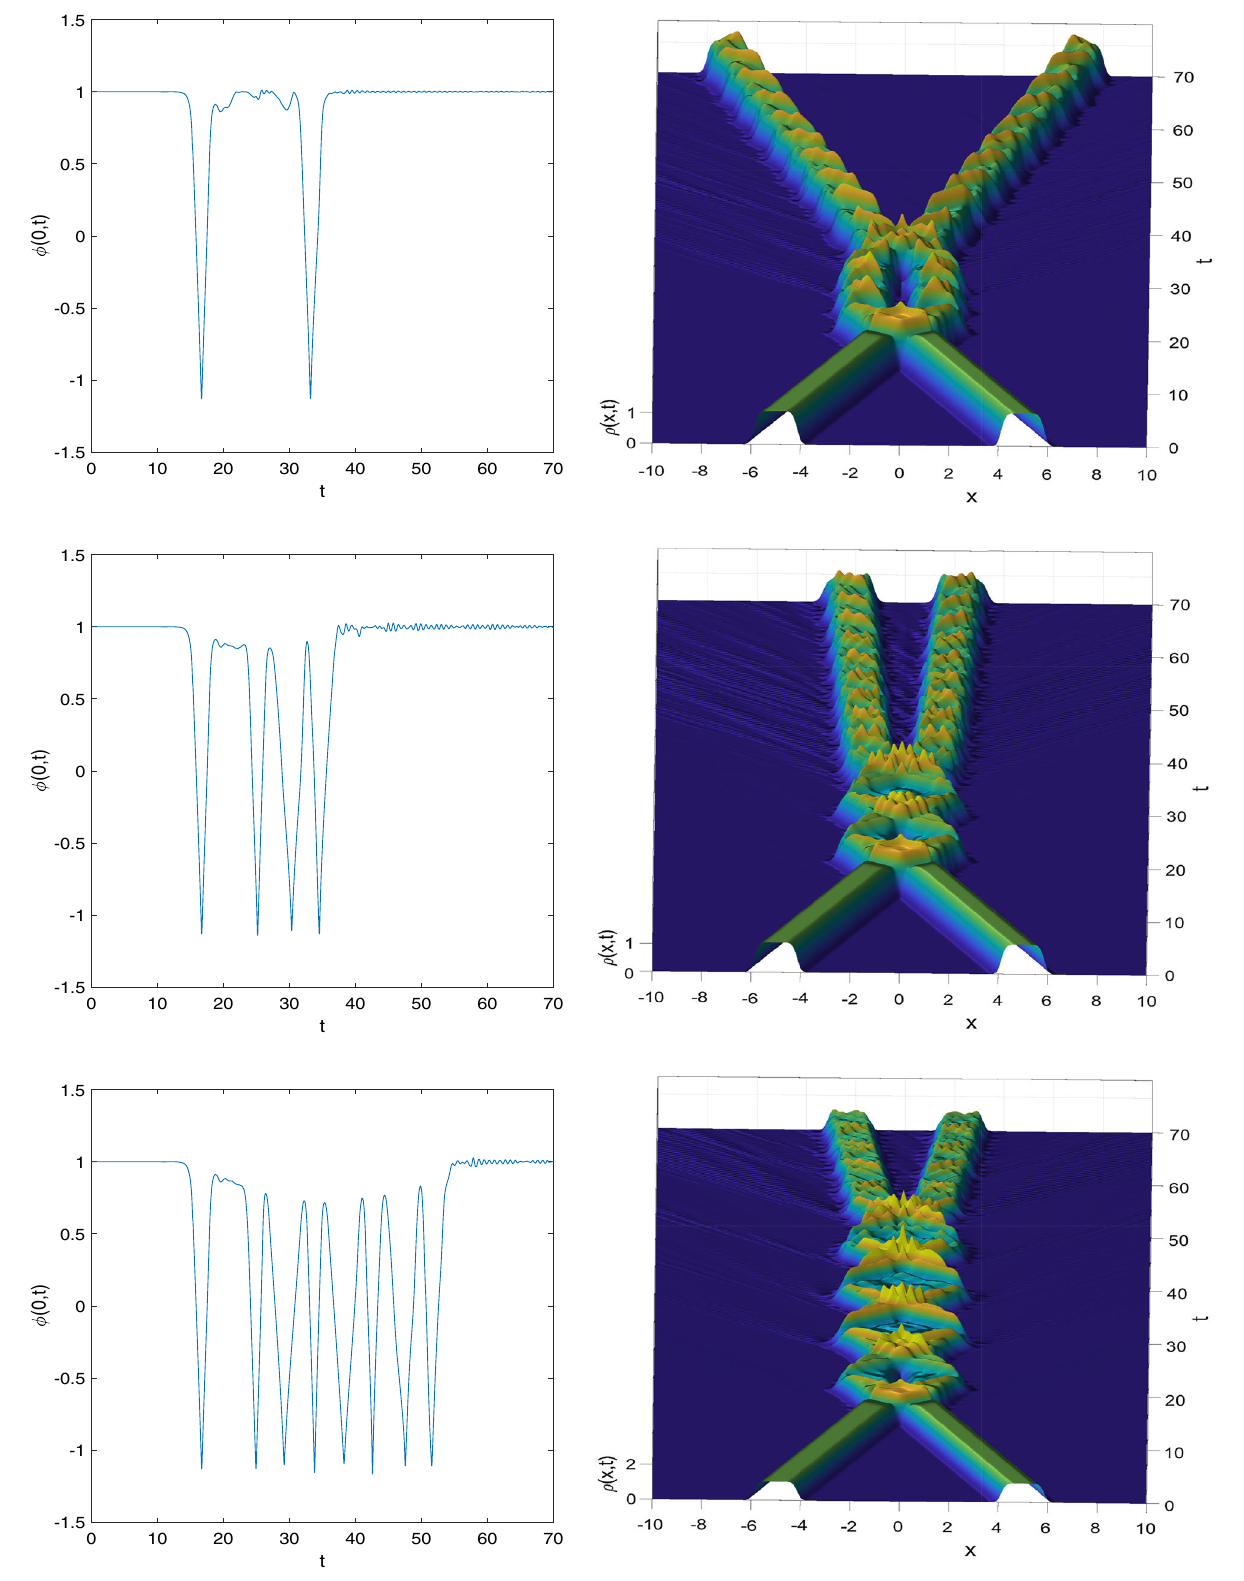
Fig. 6 Resonant 2-, 4- and 8-bounce solutions for n = 4 viewed from the plots of the scalar field at the origin (left panels) and the 3D plots of the energy density (right